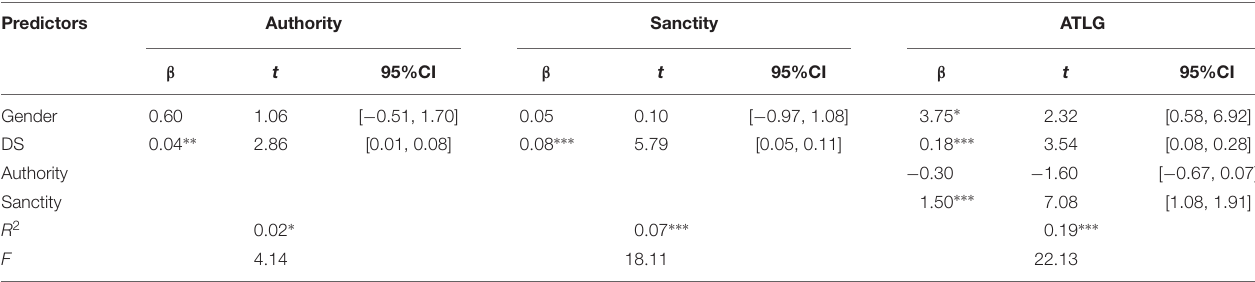
TABLE 2 | Individual associations between variables in the mediation model where authority and sanctity were hypothesized to mediate the association between disgust sensitivity and ATLG ( N = 452).